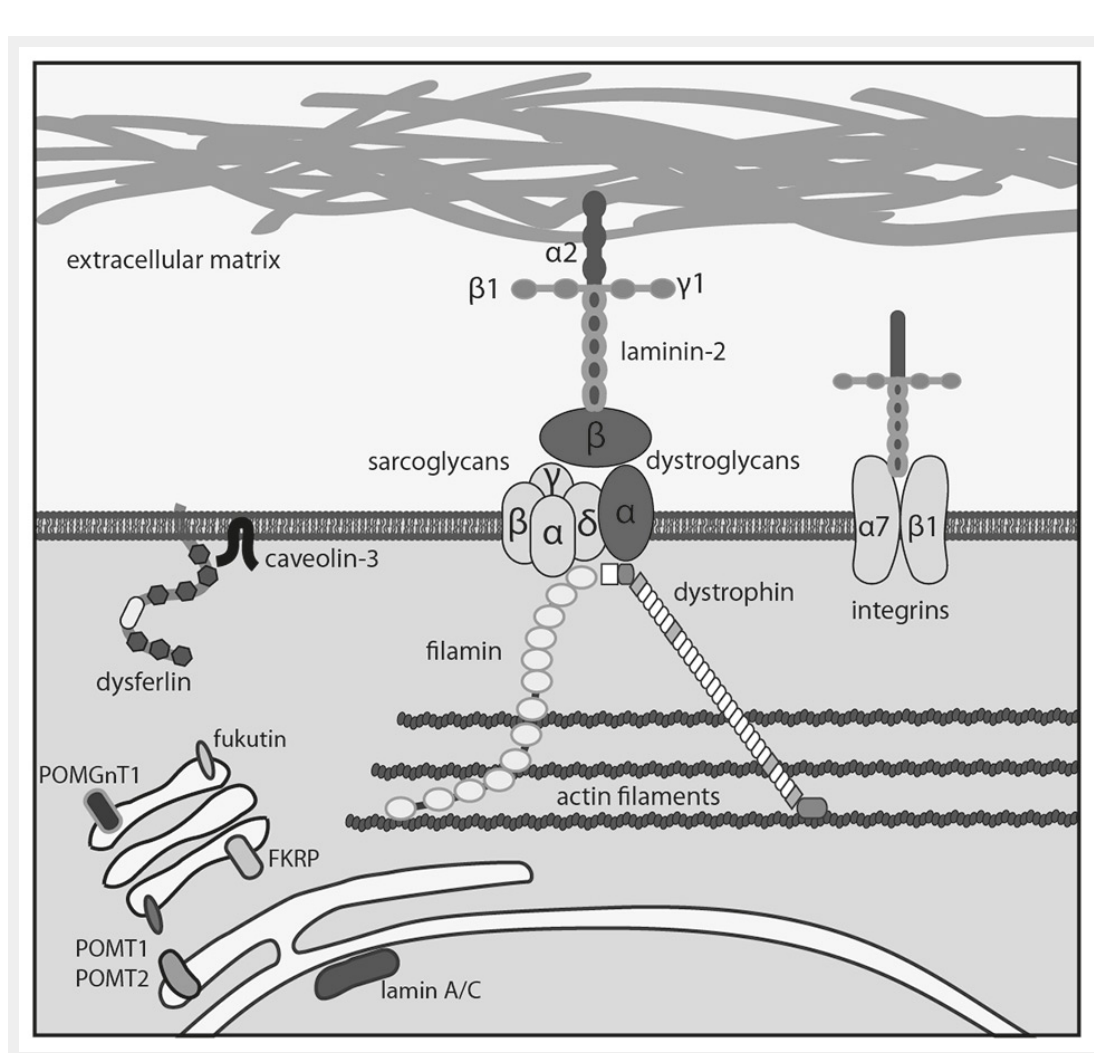
Illustration of proteins and potential targets involved in muscular dystrophies. Schematic representation of the localisation and interaction of selected proteins involved in muscular dystrophies. Dystrophin links the extracellular matrix to the actin cytoskeleton via the dystrophin-associated glycoprotein complex (DGC). Absence of dystrophin results in destabilisation of the DGC. Some genes mutated in muscular dystrophies encode proteins responsible for the correct glycosylation of dystroglycan, necessary for interaction with the extracellular matrix. The tail anchored membrane protein dysferlin is involved in membrane repair. FKRP = fukutin-related protein; POMT = protein O-mannosyl